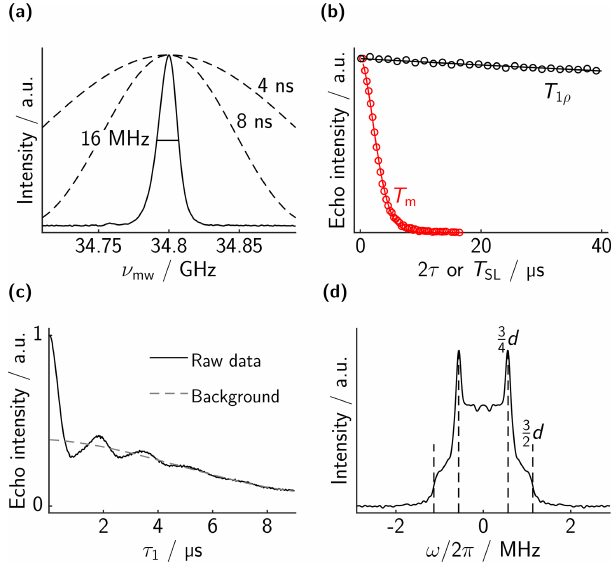
Figure 4. Measurements on bis-trityl 1 . (a) EPR spectrum. (b) Comparison of the decay of a microwave two-pulse echo (red, bare-spin decoherence) with the decay of the spin-locked echo as a function of T SL (black, dressed-spin polarization decay). Ex- perimental points in circles (not all points shown for clarity) and best fit in solid lines. The fitted values are T m = 3 . 3µs ( ξ = 5 . 3) and T 1 ρ = 560µs ( ξ = 2 . 9). (c) Dressed-spin echo evolution as a function of τ 1 = τ 2 . The dipolar oscillations are clearly visible. A stretched exponential background with T 2 ρ = 14 . 3µs ( ξ = 5 . 4) is shown in grey. (d) Dipolar spectrum obtained by a Fourier trans- form of (c) after background division. The positions of the expected singularities based on the distance of the electrons are indicated by dashed lines. Note that there are small artifact peaks outside the plotting range at ± 8MHz which we suspect to be a sampling arti-